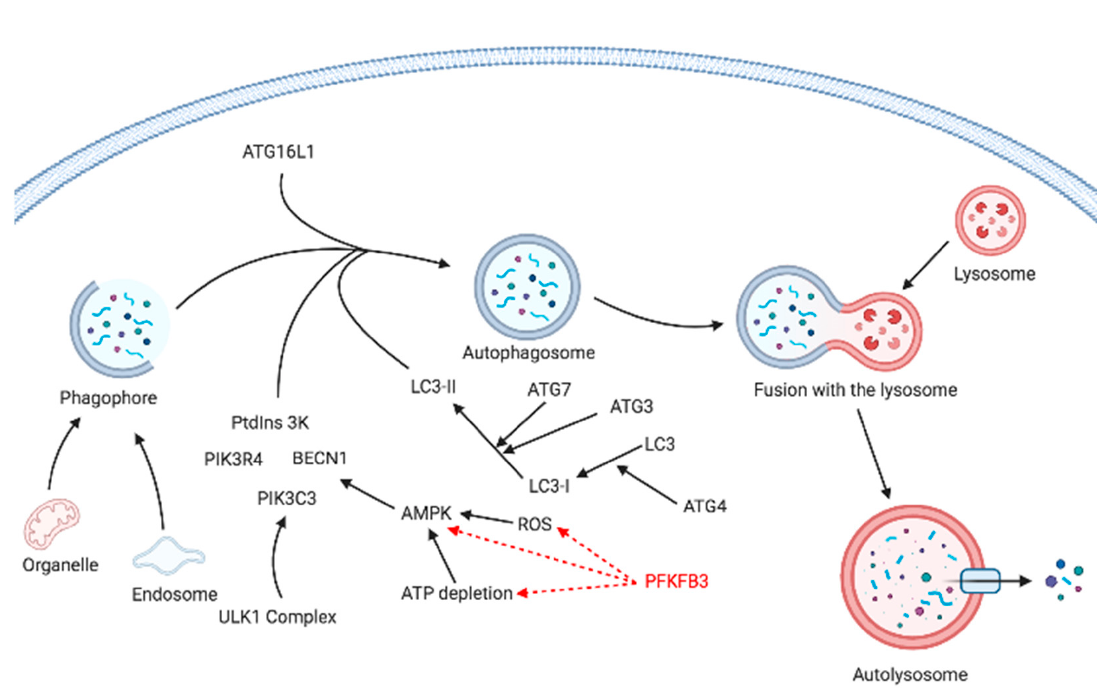
Figure 8. A brief overview of the autophagy pathway, which is a catabolic process that includes a specific intracellular cargo, such as organelles or endosomal contents that are intended for degradation. The autophagy process is initiated by an extracellular stimulus or cargo recognition that prompts the formation of the phagophore. The cargo is then engulfed within a double-membrane vesicle (an autophagosome). Increased initiation to engage phagophores for autophagy involves the activation of the ULK1 complex that further induces the nucleation complex, which includes PtdIns3K, PIK3, and BECN1. Later, LC3 is conjugated to the phagophores and is responsible for their maturation and elongation. Upon maturation, the autophagosome fuses with a lysosome, with its content being released and degraded by lysosomal enzymes. Recent evidence suggests that PFKFB3 induces autophagy through increased Nicotinamide adenine dinucleotide phosphate (NADPH) production. However, some dissertations suggest an opposite relationship—insufficient PFKFB3 activity results in lower Reactive Oxygen Species (ROS) availability and reduced autophagy. Mitochondrial damage increases ROS and decreases cellular ATP levels. ROS may activate AMP-activated protein kinase (AMPK), which positively regulates autophagy through phosphorylation of BECN1. Abbreviations: ULK1 complex—unc-51 like autophagy activating kinase 1 complex, PIK3C3—phosphatidylinositol 3-kinase catalytic subunit type 3, PIK3R4—phosphatidylinositol 3-kinase regulatory subunit 4, BECN1—Beclin 1, PtdIns 3K—phosphatidylinositol 3-kinase, LC3—Microtubule-associated proteins 1A/1B light chain 3B, LC3-I—cytosolic form of LC3, LC3-II—lipid modified form of LC3, ATG—autophagy-related protein. Created with